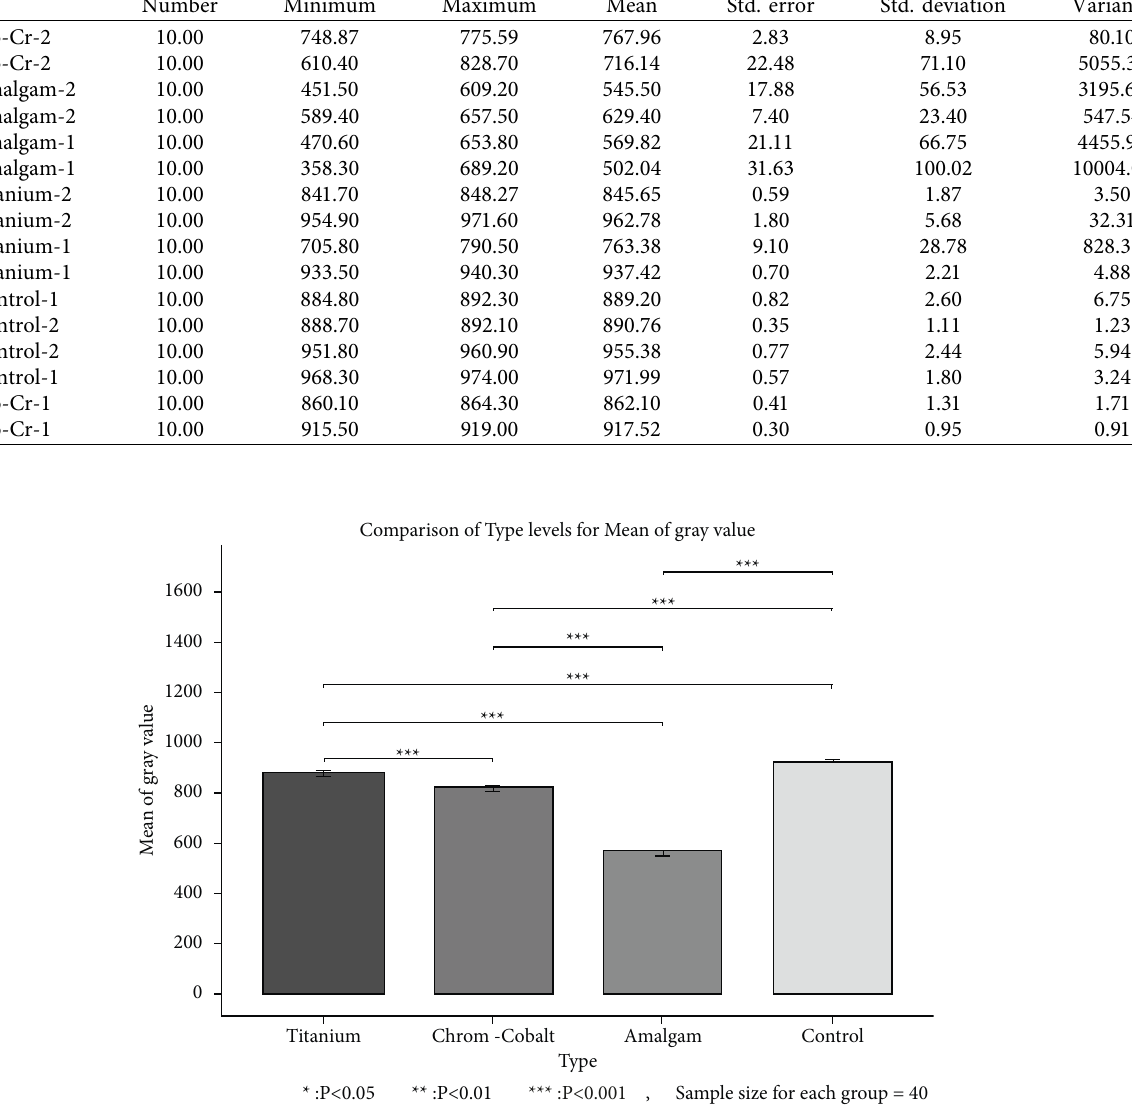
Figure 3: Pairwise comparisons of different metal objects regarding their effect on the mean